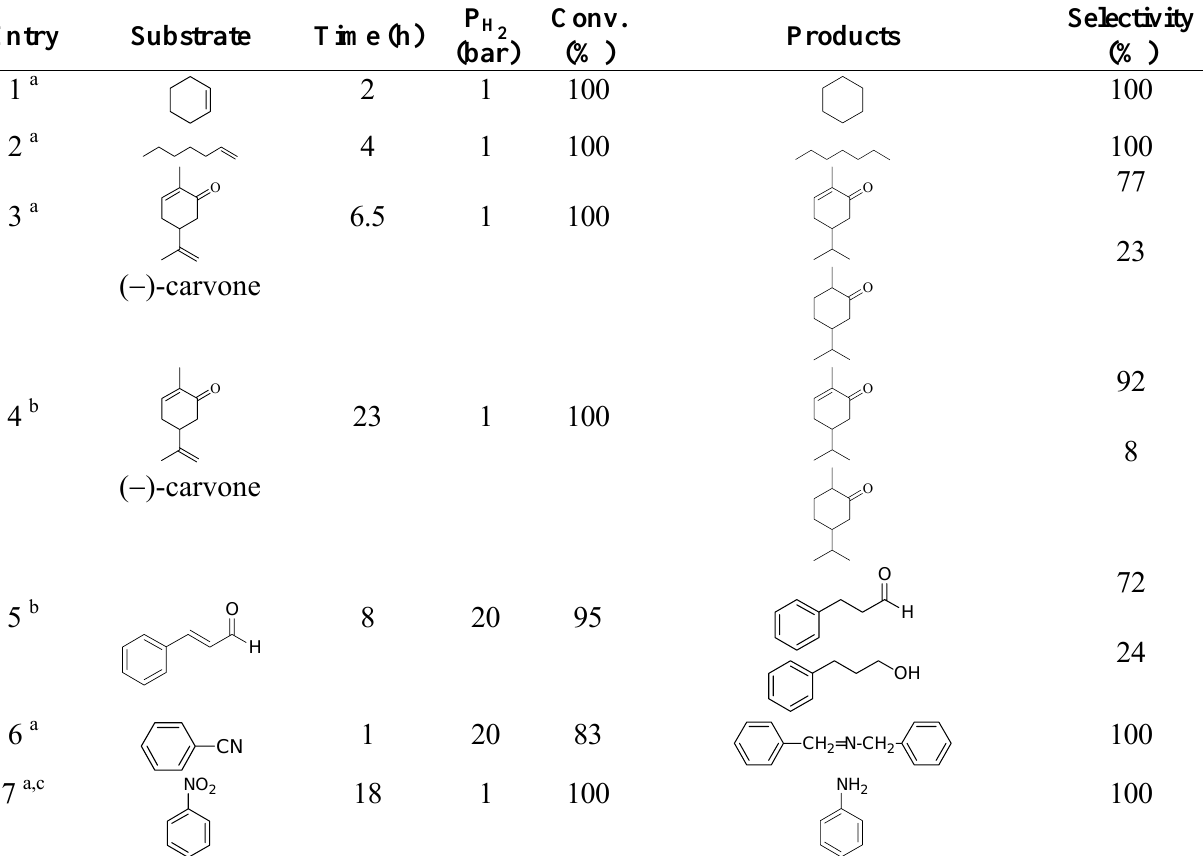
1. Catalytic hydrogenations promoted by Rh-pol. Reaction conditions: